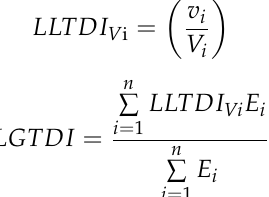
Figure 9. The cumulative damage energy dissipation of the concrete lining is subjected to the different duration of NFGMs.